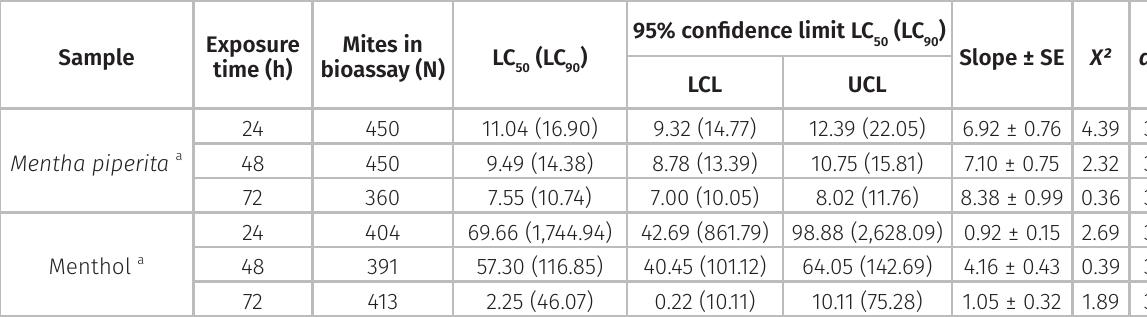
Table II. Fumigant toxicity of Mentha piperita L. essential oil and its major compound against Tetranychus urticae after 24, 48, and 72 h of